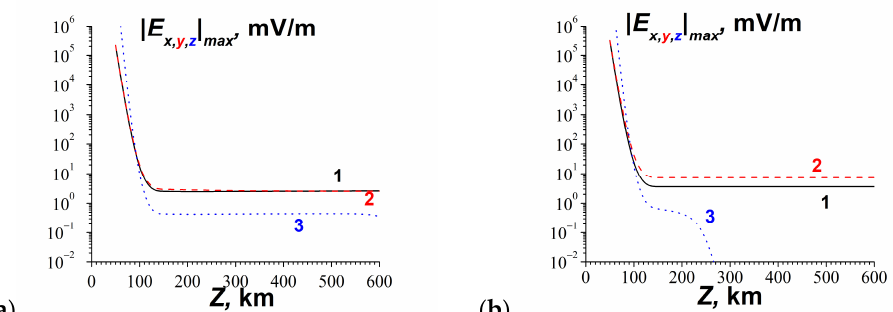
Figure 8. The dependencies of the maximum values of the electric field components on the vertical coordinate obtained in the dynamic simulations, part ( a ), and in the quasi-electrostatic ones, part ( b ). The frequency is ω = 0.025 s − 1 . The geomagnetic field inclination is θ i = 10 ◦ . The case of closed geomagnetic field lines is considered. The total vertical distance of the simulation is L z = 2000 km. The curves 1, 2, 3 are the maximum values of |E x |, |E y |, |E z | components correspondingly. Leaving empty space in the lower atmosphere area as in Figure 5a–c and in Figures 7, 8 and 13, corresponds to the rejection of claims for an adequate definition of the electric field in the external current region, introduced instead of an synergetic self-consistent definition of current and field, as explained in detail in the introduction to this work, as well as in [15].